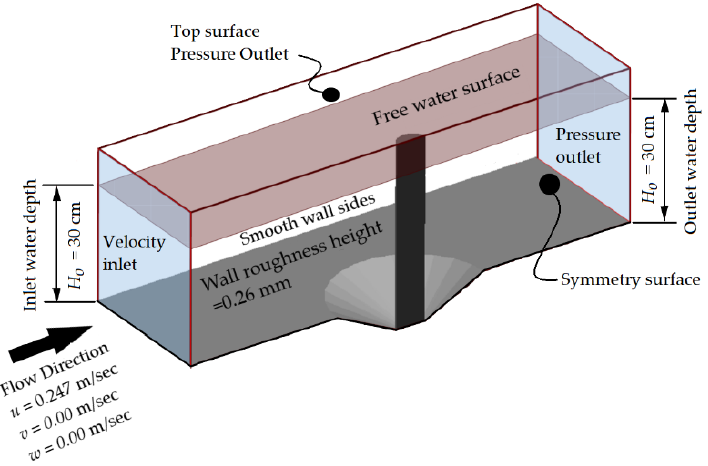
Figure 3. Coordinate system.